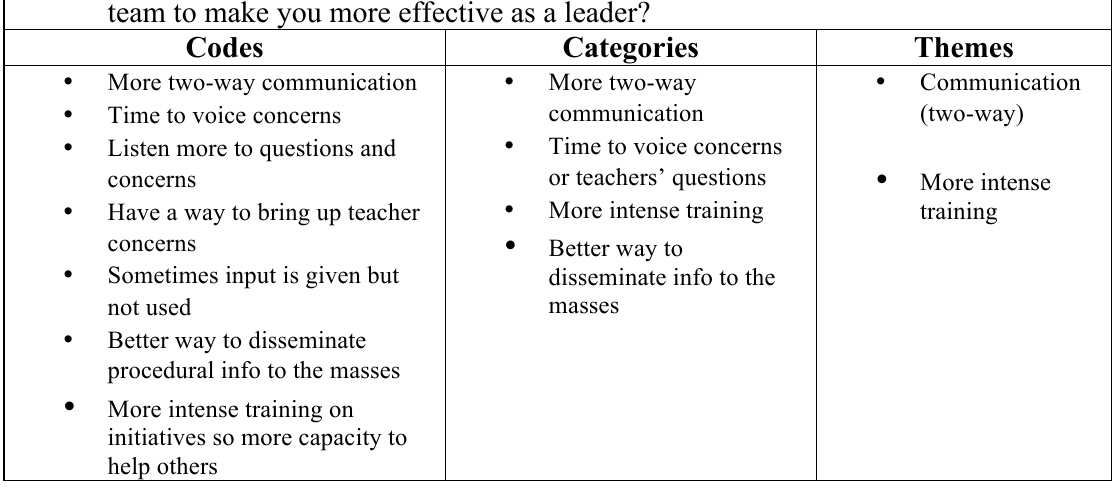
Leadership Team Members’ Question Ten and